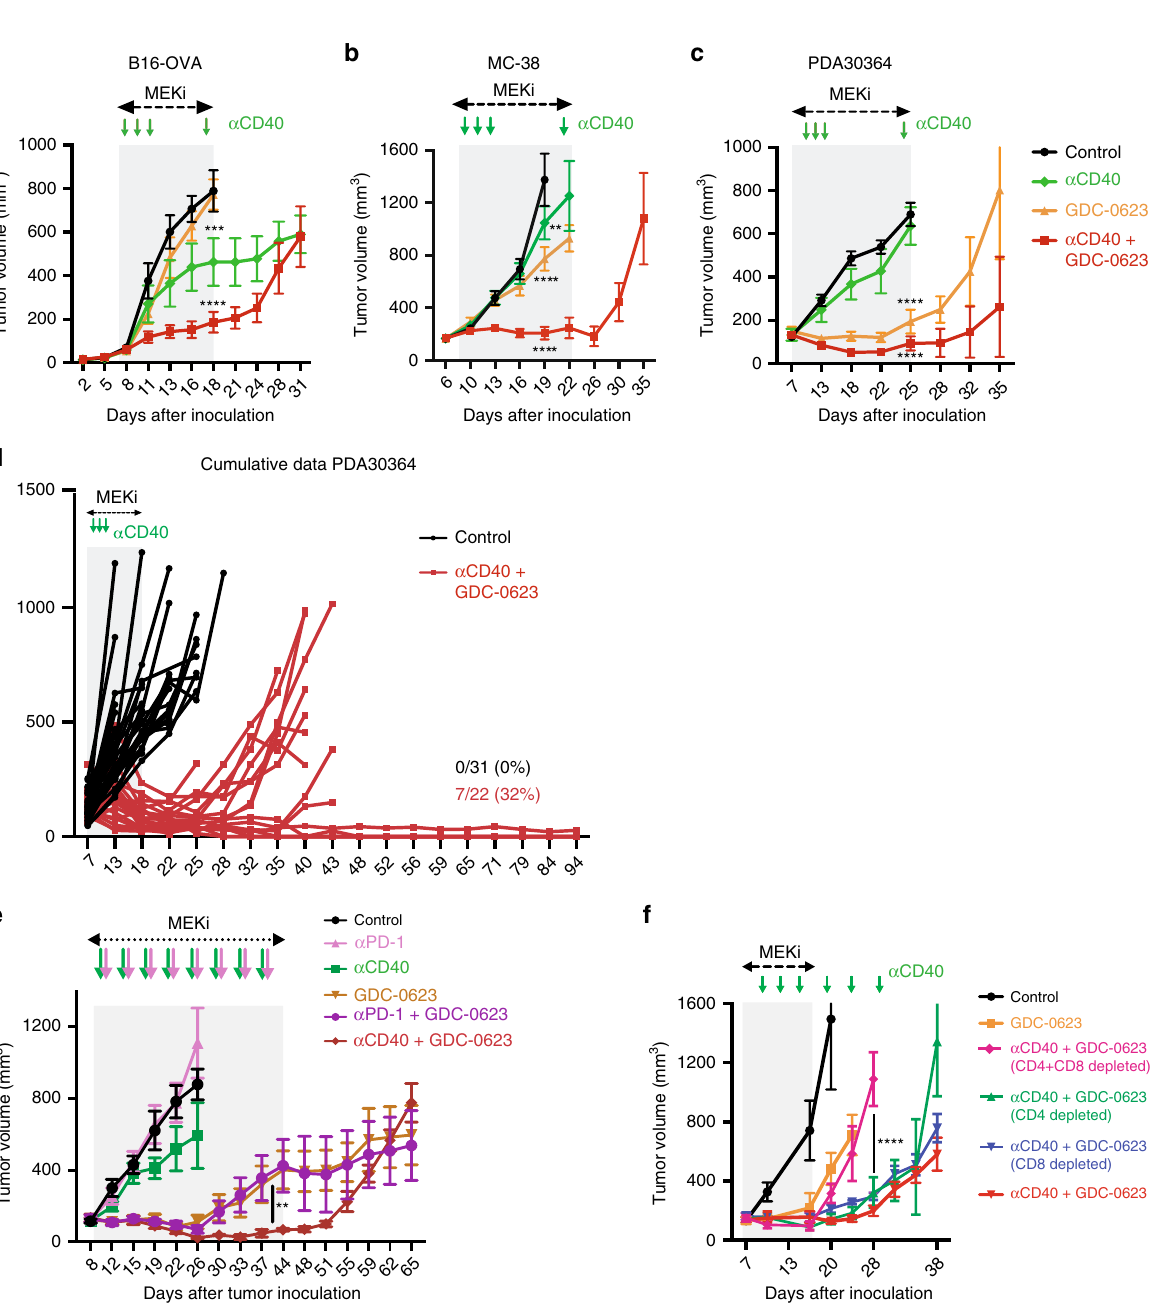
Fig. 3 Combination of MEK inhibition with agonist anti-CD40 Ab mediates control of established tumors. a – c Outgrowth of B16-OVA, MC-38, and PDA30364 tumors upon treatment with MEKi GDC-0623 and/or anti-CD40 Ab. Mice were treated daily with 30 mg kg − 1 GDC-0623 or vehicle for ~2 weeks (gray rectangle). Anti-CD40 or control Ab were administered on treatment days 3, 5, 7 as well as 1 day prior to biomarker analyses (green arrows). Each group consisted of at least six mice ( n B16-OVA = 10, n MC38 = 10, n PDA30364 = 10). Four mice per group were killed at end of treatment for biomarker analyses. Two-way ANOVA with post hoc Dunnett ’ s test; treatment groups vs. control. Signi fi cance levels are indicated by asterisks (* p ≤ 0.05; ** p ≤ 0.01; *** p ≤ 0.001; **** p ≤ 0.0001). d Cumulative data of several experiments with the PDA30364 tumor model. e PDA30364 tumor growth in mice treated with monotherapies (anti-CD40 Ab, anti-PD-1 Ab, or GDC-0623) and combination therapies (anti-CD40 Ab + GDC-0623 and anti-PD-1 Ab + GDC-0623). Mice were treated daily with 30 mg kg − 1 GDC-0623 or vehicle for ~5 weeks. Anti-CD40, anti-PD-1, and control Ab were administered twice weekly (arrows). Each group consisted of at least nine mice ( n Control = 9, n CD40 = 9, n GDC-0623 = 12, n CD40 + GDC-0623 = 10, n PD-1 = 10, n PD1-GDC-0623 = 11). Four mice per group were killed 2 weeks after treatment start for biomarker analyses. f Impact of T cell depletion on ef fi cacy of GDC-0623 and/or anti- CD40 Ab treatment against PDA30364 tumors. Where indicated, groups received depletory anti-CD4, anti-CD8 or anti-CD4 + anti-CD8 Abs twice per week. Each group consisted of at least fi ve